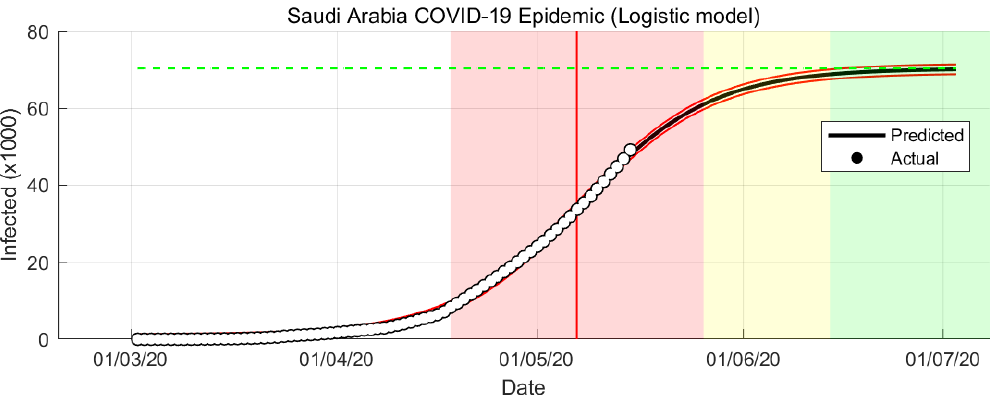
Figure 3. COVID-19 epidemic in Saudi Arabia prediction based on Logistic Growth model.